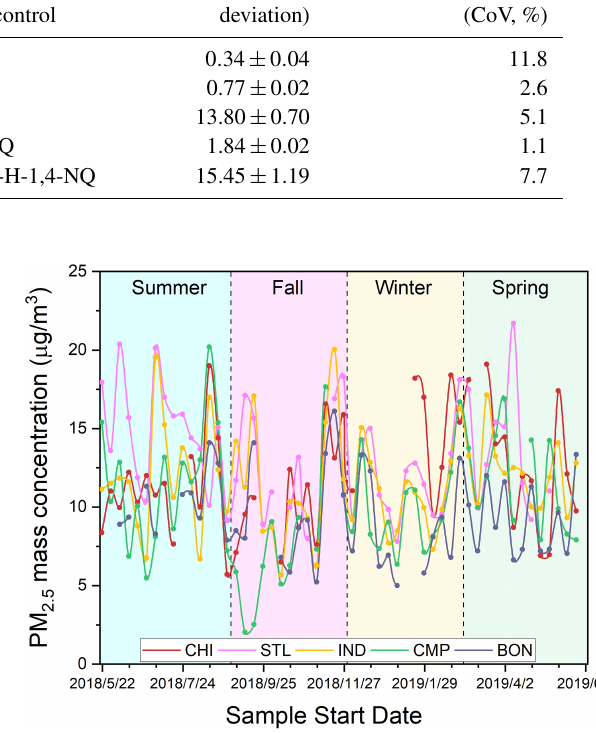
Figure 2. Time series of PM 2 . 5 mass concentrations at our sampling sites in the Midwestern